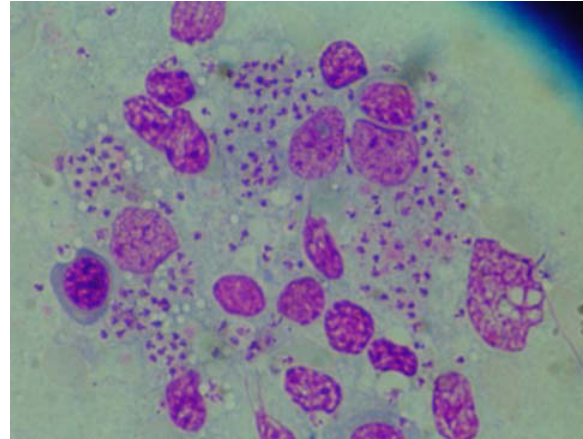
Figure 5. Amastigotes forms of Leishmania spp by Giemsa stain.